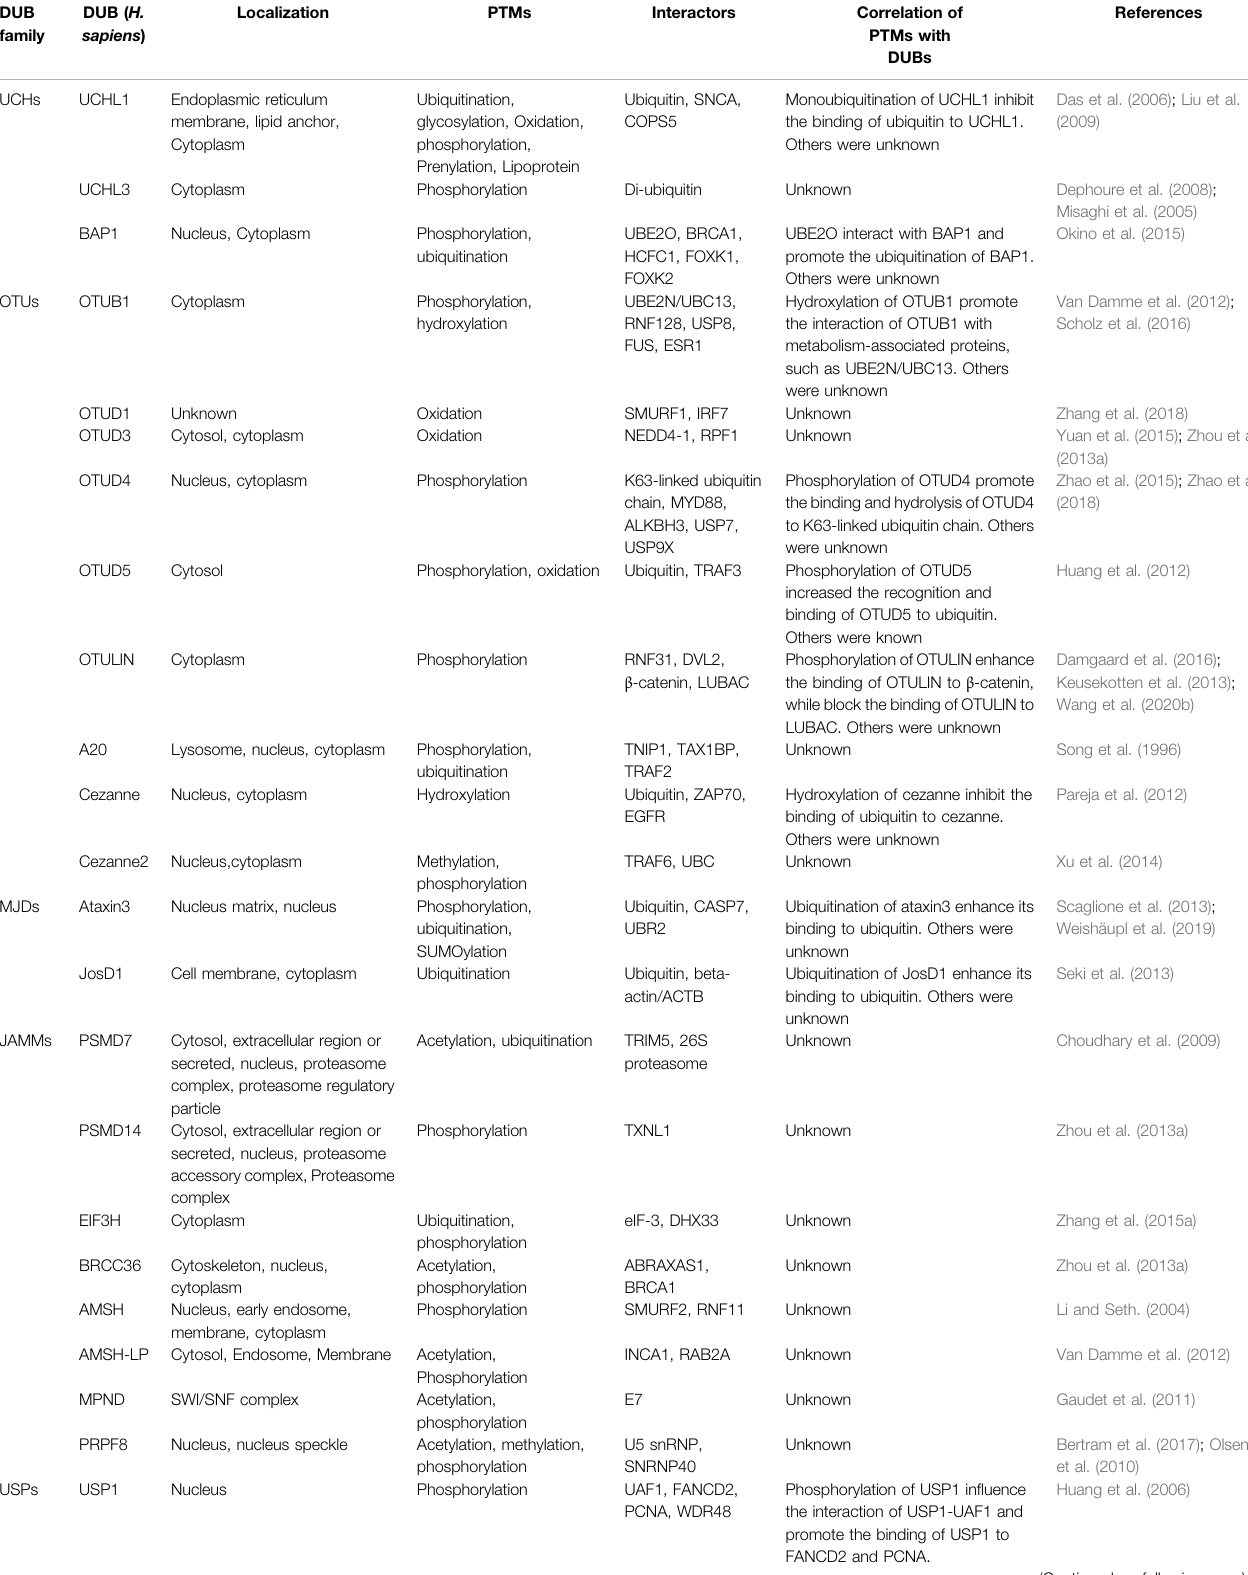
TABLE 1 | Summary of DUBs localization, PTMs and interaction pro fi